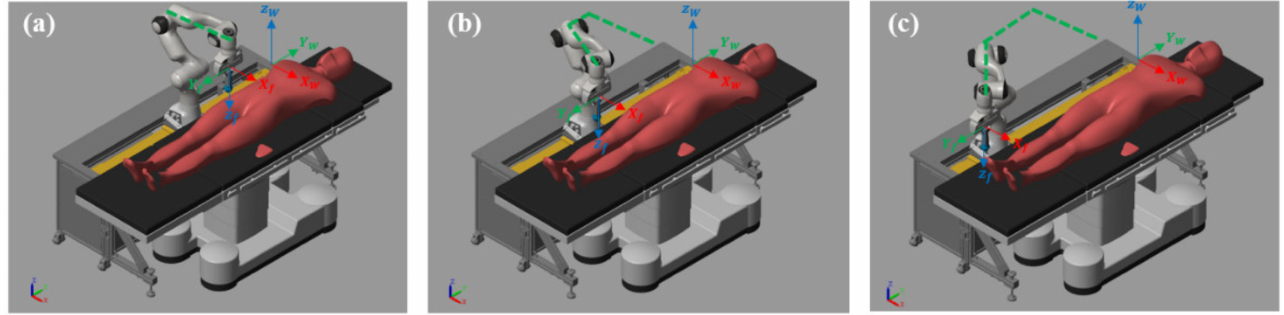
Figure 9. Sequential evolution of the robot configuration during the execution of a linear trajectory of